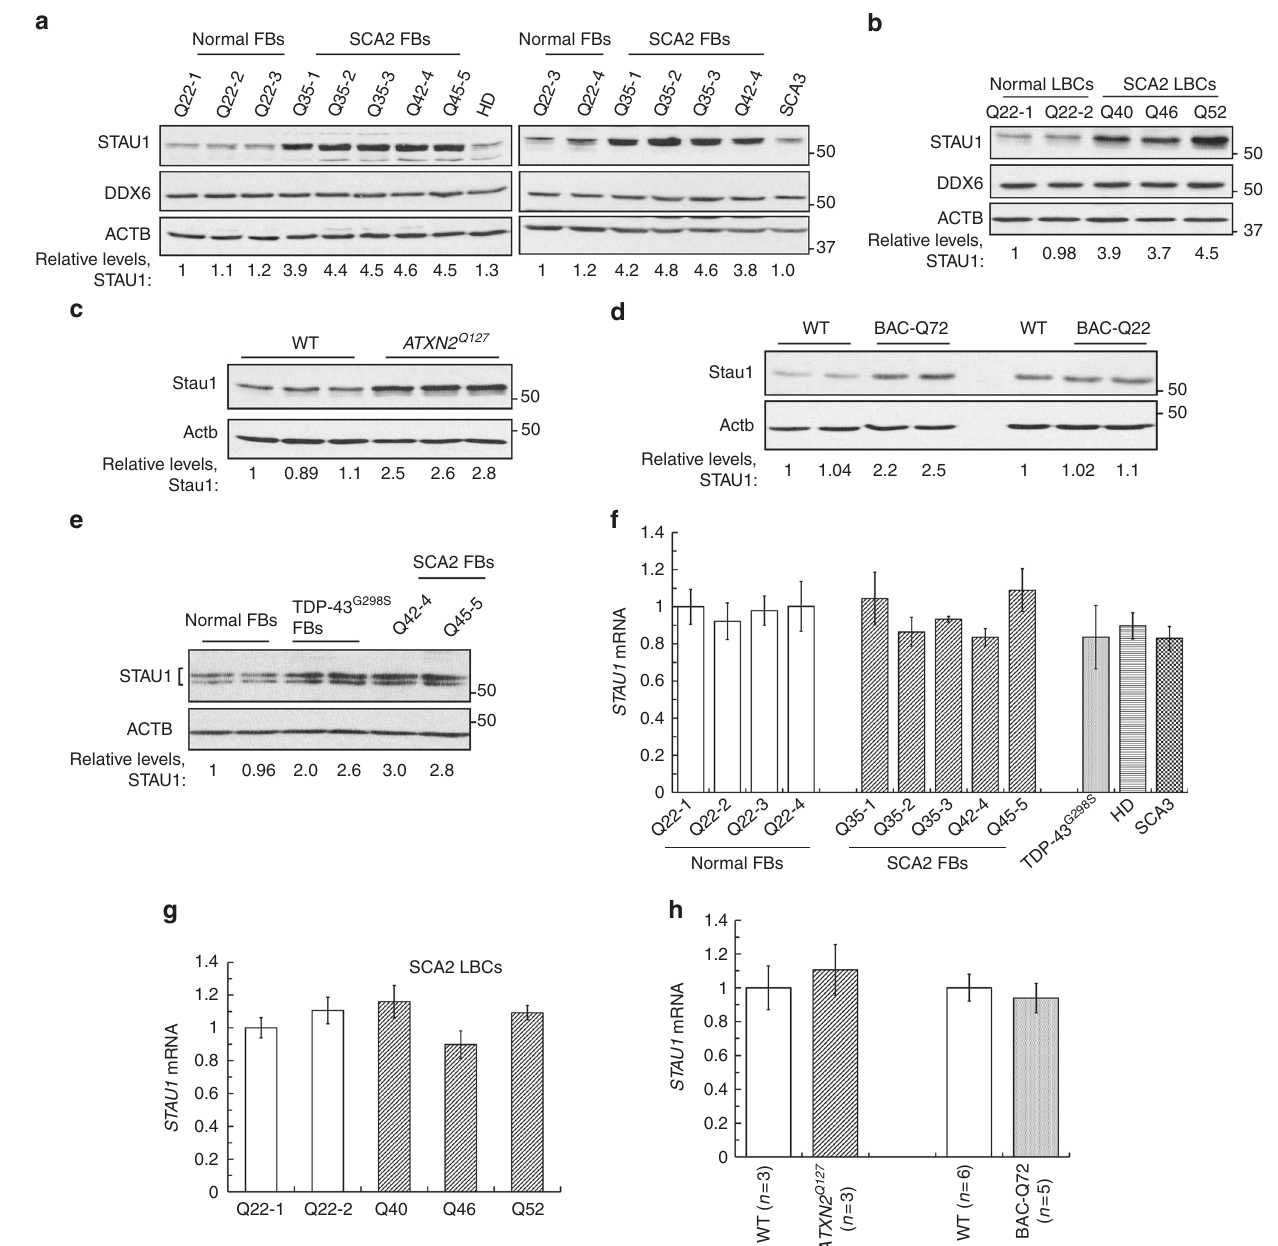
Fig. 2 Staufen1 protein but not mRNA steady-state levels are increased in neurodegenerative disease cells and tissues. Western blot analysis of SCA2- FBs ( a ) and LBCs ( b ) show increased STAU1 levels compared with normal controls. DDX6 levels are unchanged. HD and SCA3 patient (polyQ expanded) FBs were used as additional controls. Four normal and fi ve SCA2 FBs, and two normal and three SCA2 LBCs were used. c , d Western blot analyses of ATXN2 Q127 ( c ) and BAC-Q72 ( d ) mouse cerebellar extracts (24 weeks of age) showing increased Stau1 levels compared with wild-type or BAC-Q22 controls ( n = 2 – 3 animals per group). e Western blot of FB extracts from an ALS patient with the TDP-43 G298S mutation show increased STAU1 levels. β - Actin was used as loading control and representative blots of three independent experiments are shown. f – h STAU1 RNA levels are unaltered in SCA2 and ALS cells and SCA2 mice. qRT-PCR analyses of STAU1 mRNA in SCA2 FBs and ALS FB with TDP-43 G298S mutation ( f ) or SCA2 LBCs ( g ). h qRT-PCR analyses of cerebellar RNAs from ATXN2 Q127 and BAC-Q72 mice compared to wild-type littermates (24 weeks of age; n = animals per group). Gene expression levels were normalized to